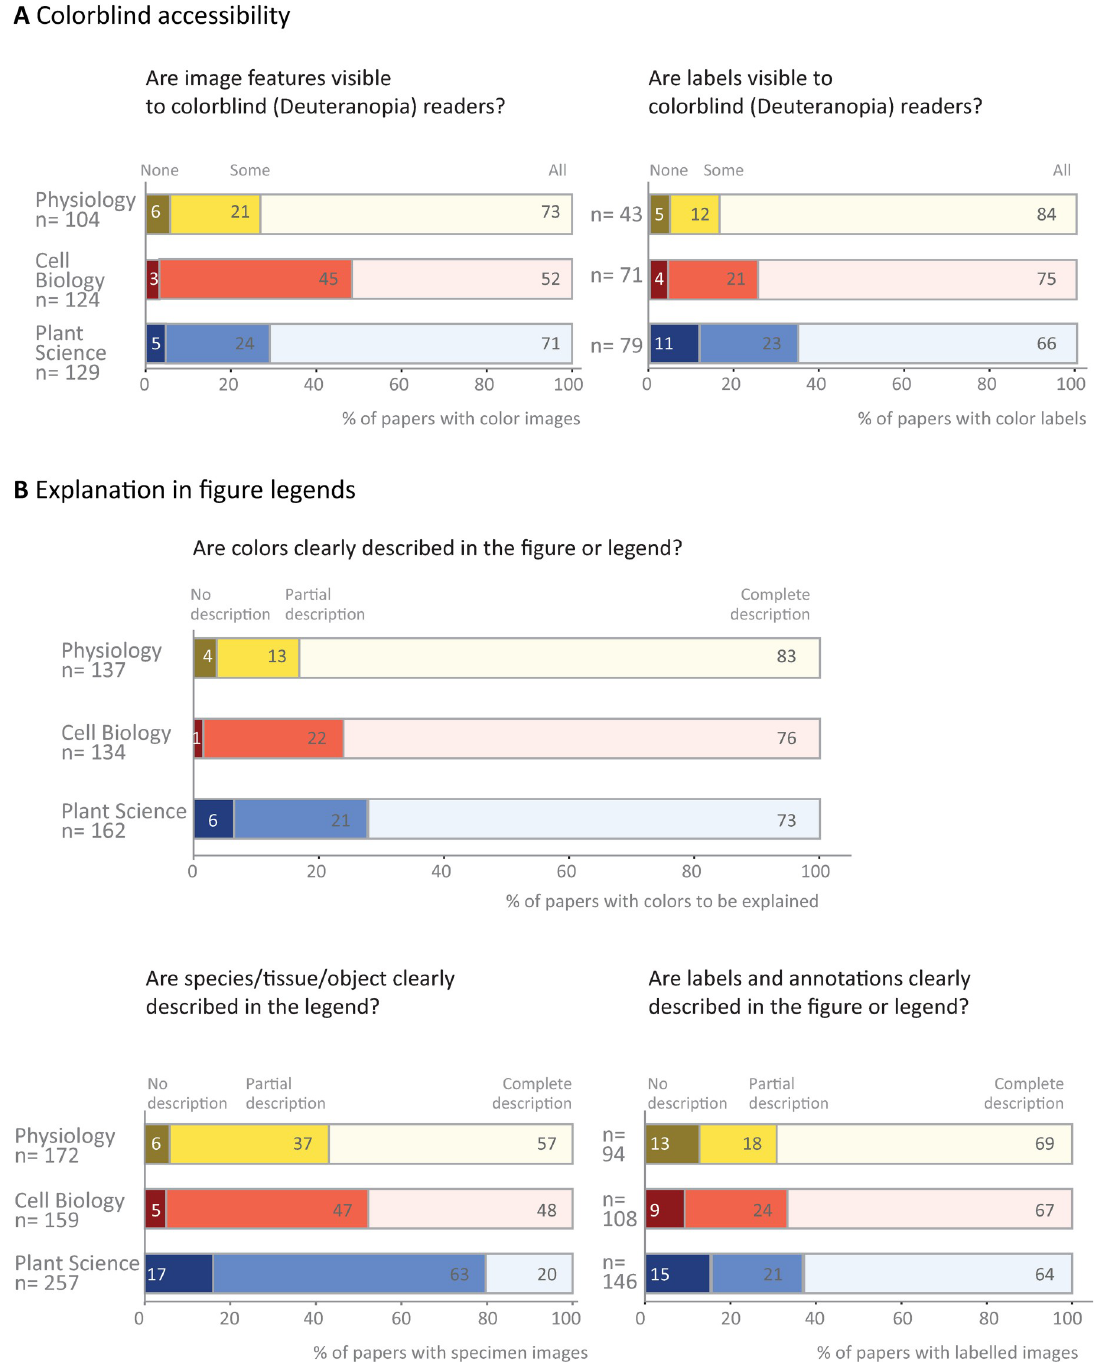
Fig 2. Use of color and annotations in image-based figures. (A) While many authors are using colors and labels that are visible to colorblind readers, the data show that improvement is needed. (B) Most papers explain colors in image-based figures; however, explanations are less common for the species and tissue or object shown, and labels and annotations. Totals may not be exactly 100% due to rounding.